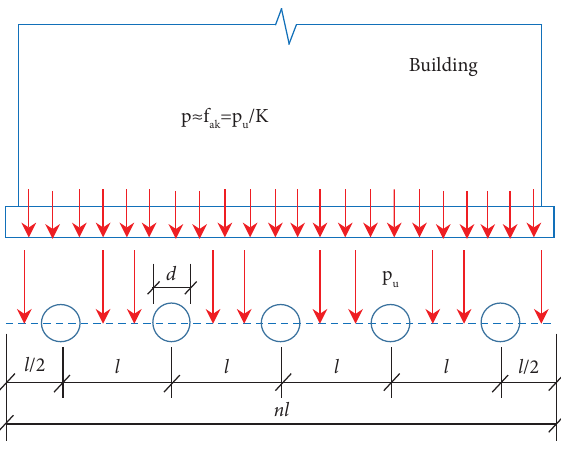
Figure 3: Analysis sketch for the ultimate spacing of holes.